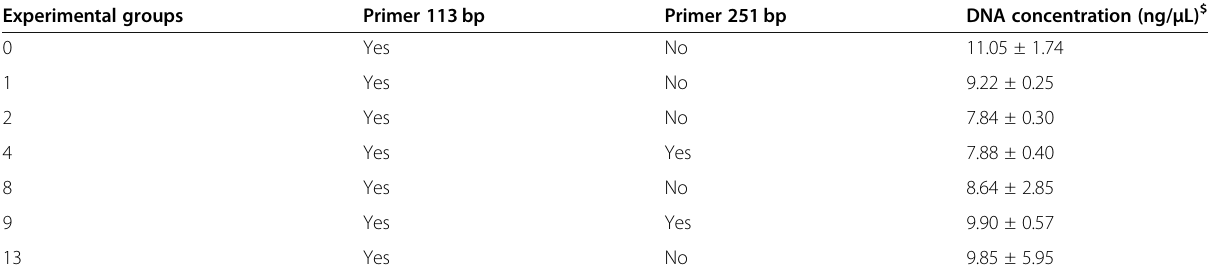
Table 4 Qualitative and quantitative analysis of nuclear DNA amplification by different two primer length (113 and 251 bp) in bone processed demineralization Experimental groups